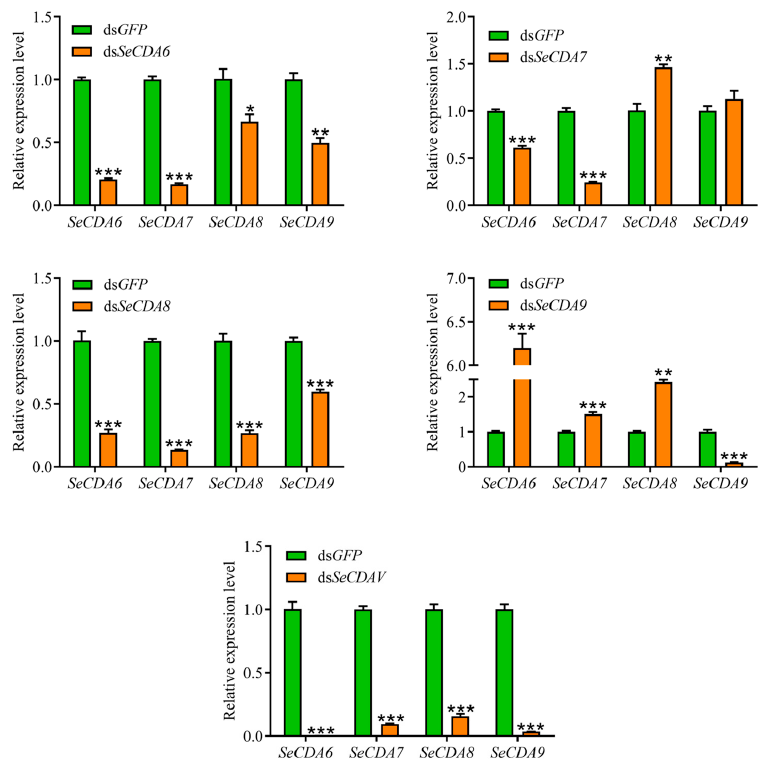
Figure 6. Relative expression levels of SeCDAs in S. exigua larvae injected with dsRNA- SeCDAs / GFP . Data are reported as means ± SE of three independent biological replications. (*** p < 0.001; ** p < 0.01; * p < 0.05).